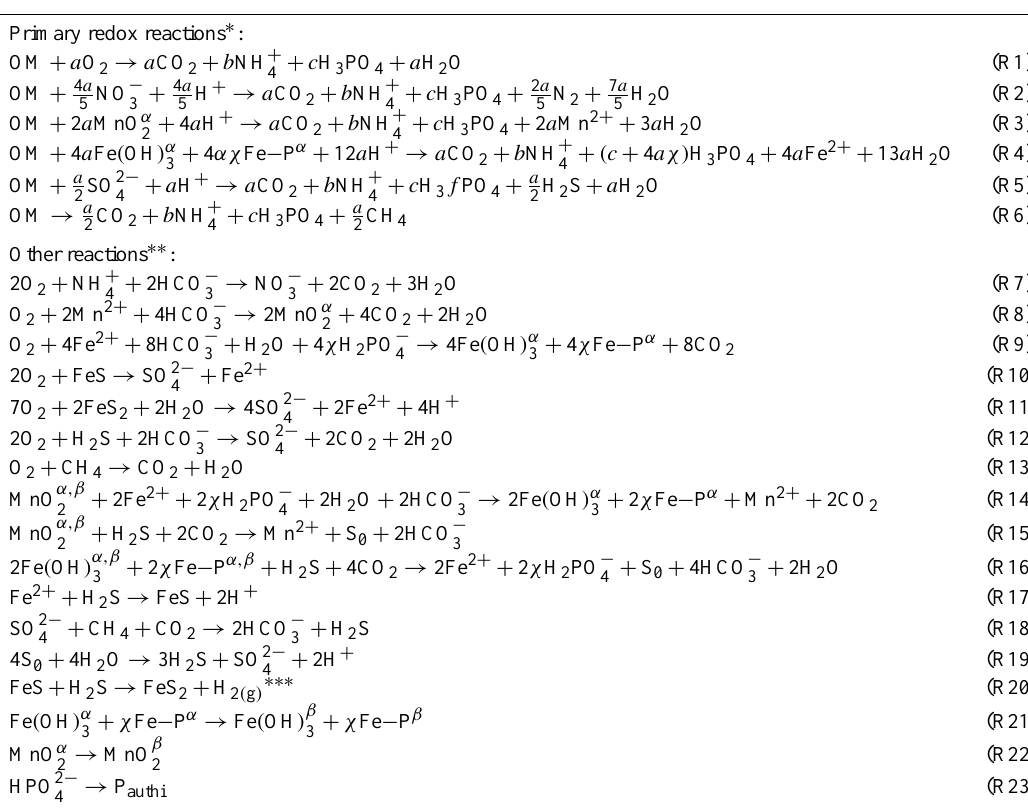
Table 4. Chemical reactions included in the model, after Reed et al. (2011b). Primary redox reactions ∗